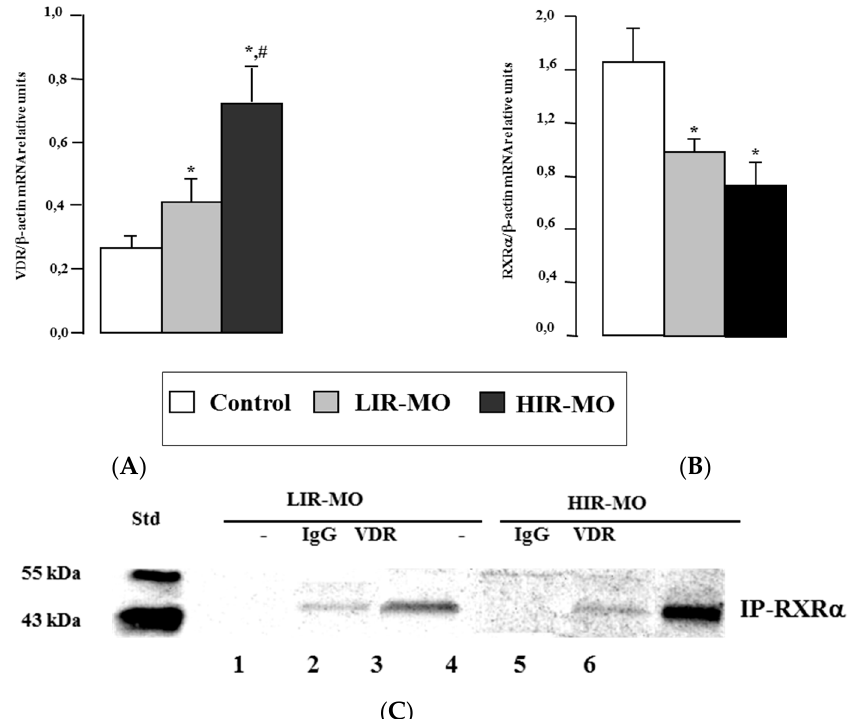
Figure 2. VDR ( A ) and RXRa ( B ) mRNA expression of VAT obtained from control, LIR-MO and HIR-MO subjects. The mRNA expression of these NRs was normalized to aP2 level. Results were expressed as the mean ± SEM and significance of differences * p < 0.05, between control vd MO groups, and # p < 0.01 between LIR-MO and HIR-MO.VDR coimmunoprecipitates with RXRa in nuclear extracts from VAT of the MO. Nuclear extracts of the VAT expressing VDR were preincubated with 1,25-(OH)2D3 ( C ) for 2 h before they were subjected to immunoprecipitation using rat antihuman RXR antibodies (lanes 3 and 6) or purified rat IgG (lanes 2 and 5) as a control. The VDR with RXRa in the protein complexes recovered by immunoprecipitation were detected by Western immunoblot (IB) analysis using rabbit antihuman VDR antibodies ( C ). Ten micrograms of